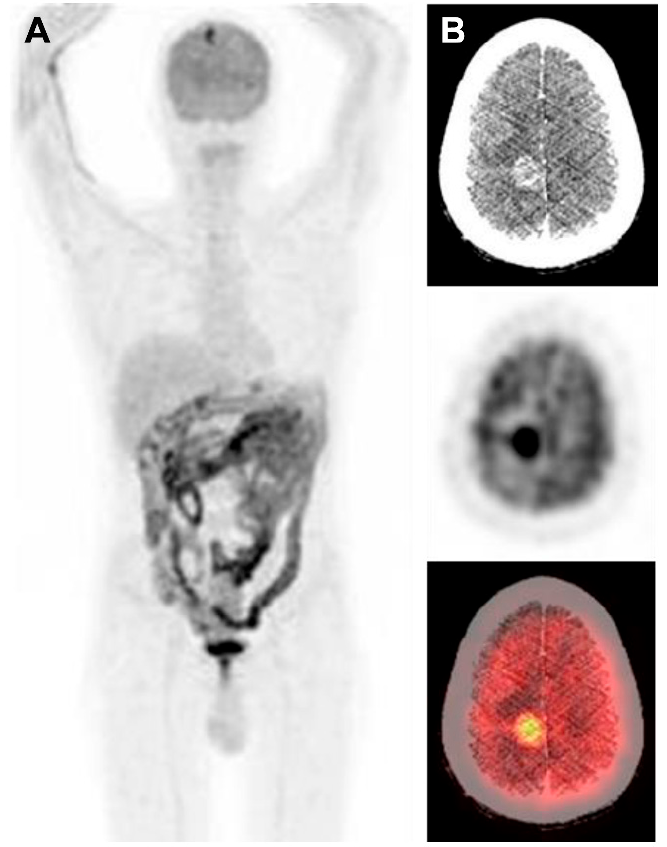
Figure 2. Patient showed no neurologic symptoms nor had been previously treated with steroids, therefore, underwent immunotherapy with ipilimumab in combination with nivolumab [2,3]. During immunotherapy, a reduction of the number and volume of subcutaneous nodules